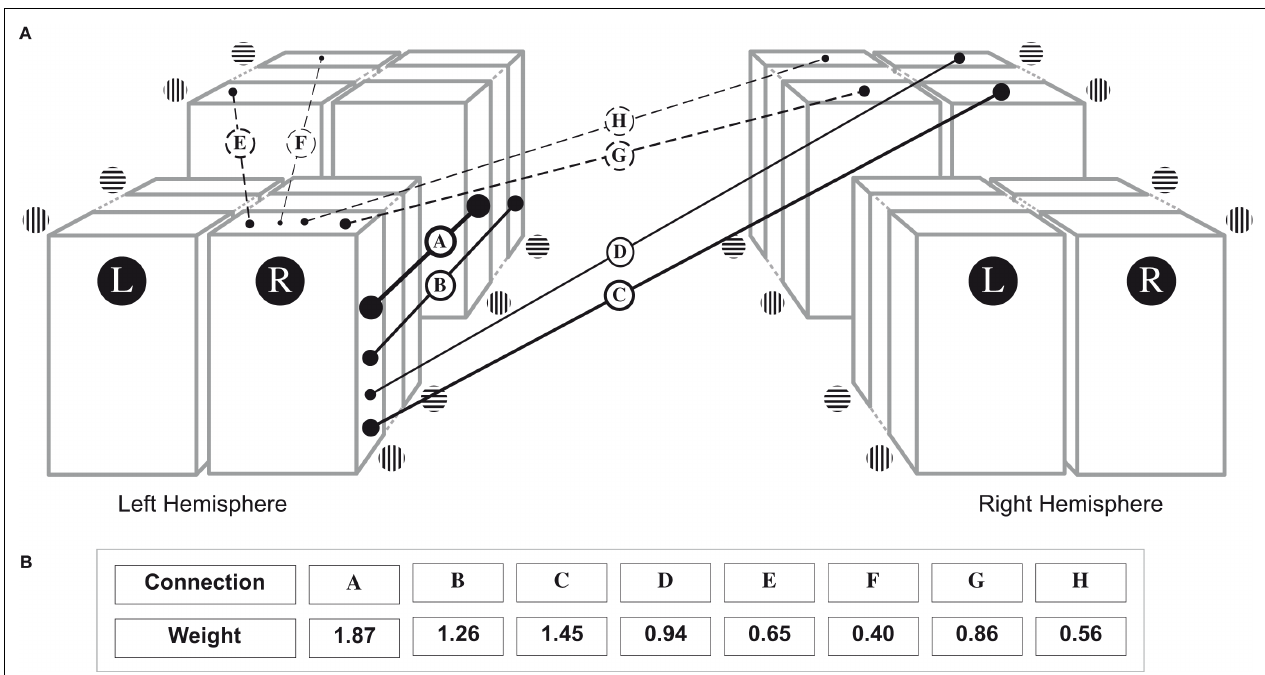
lines indicate connections between ocular dominance columns representing the same eye (and different retinal locations). Dashed lines represent connections between ocular dominance columns representing different eyes (and different retinal locations).The thickness of each line is adjusted to the weight of the connection. (B) Relative weights of each connection in A.The weight for each line is a direct representation of the data presented in Figure 3